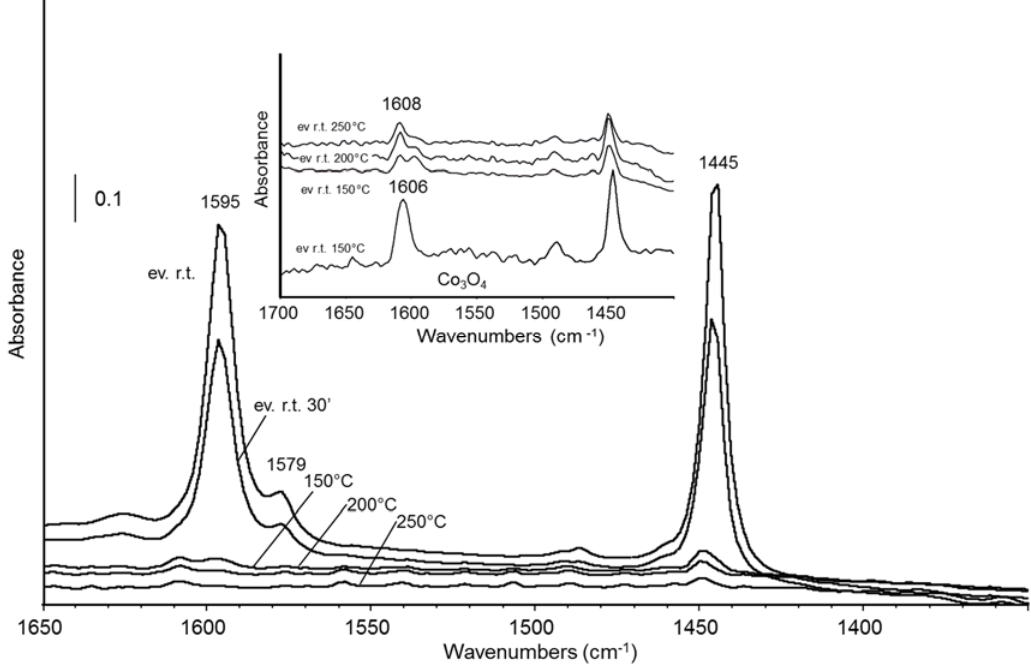
Figure 2. FT-IR subtraction spectra of surface species arising from pyridine adsorption over fresh 30Co/SBA catalyst. Inset: magnification of spectra recorded at high temperature. The spectrum of pyridine adsorbed over the reference Co 3 O 4 has been reported for comparison.